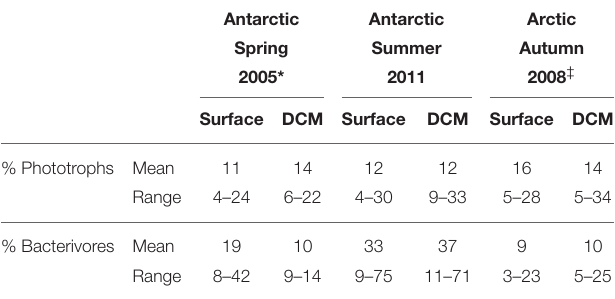
Antarctic Antarctic Arctic Spring